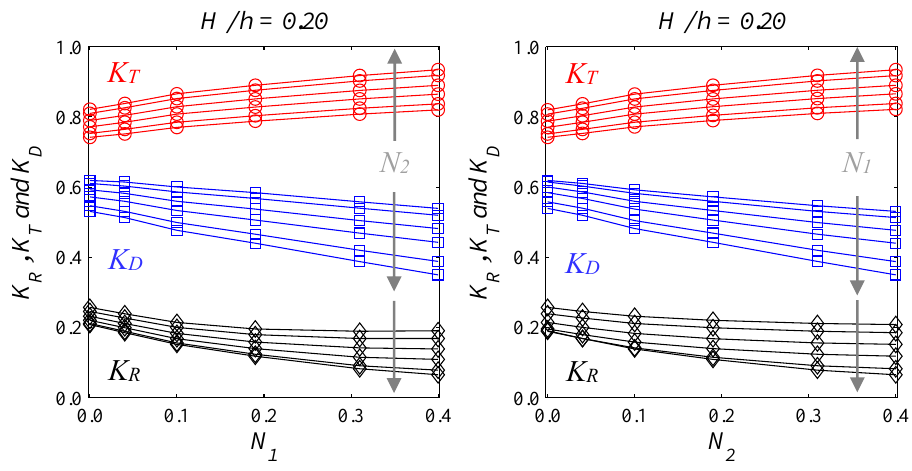
Figure 11. Effects of N 1 with respect to N 2 (left column) and N 2 with respect to N 1 (right column) on the hydraulic performance, for the case of H / h = 0.20. Black, red and blue colors represent K R , K T and K D , respectively.